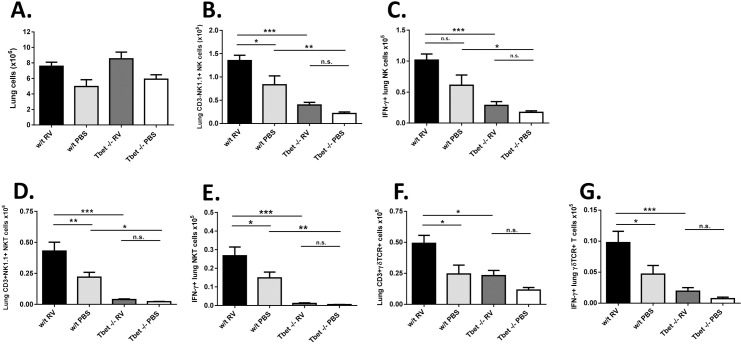
Effect of Tbet deficiency on innate cellular responses to RV.Wild type and Tbet-/- mice were infected intranasally with RV1B or sham infected with PBS. On day 2 post-challenge lungs were harvested and flow cytometry staining was performed. For intracellular cytokine staining, lung cells were stimulated with PMA and ionomycin. (A) Total numbers of lung cells. (B-G) Numbers of CD3+NK1.1- Natural Killer (NK) cells (B), IFN-γ expressing NK cells (C), CD3+NK1.1+ NKT cells (D), IFN-γ expressing NKT cells (E), CD3+γδTCR+ T cells (F) and IFN-γ expressing CD3+γδTCR+T cells (G). n = 7–8 mice/group. ***p<0.001, **p<0.01, *p<0.05, n.s. not significant.